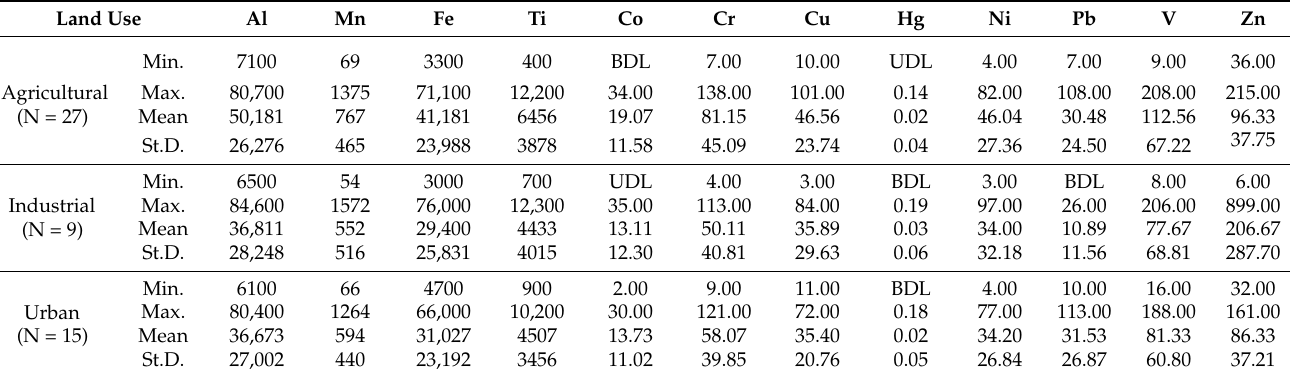
Table 1. Descriptive statistics of PTEs (ppm) in different land-use